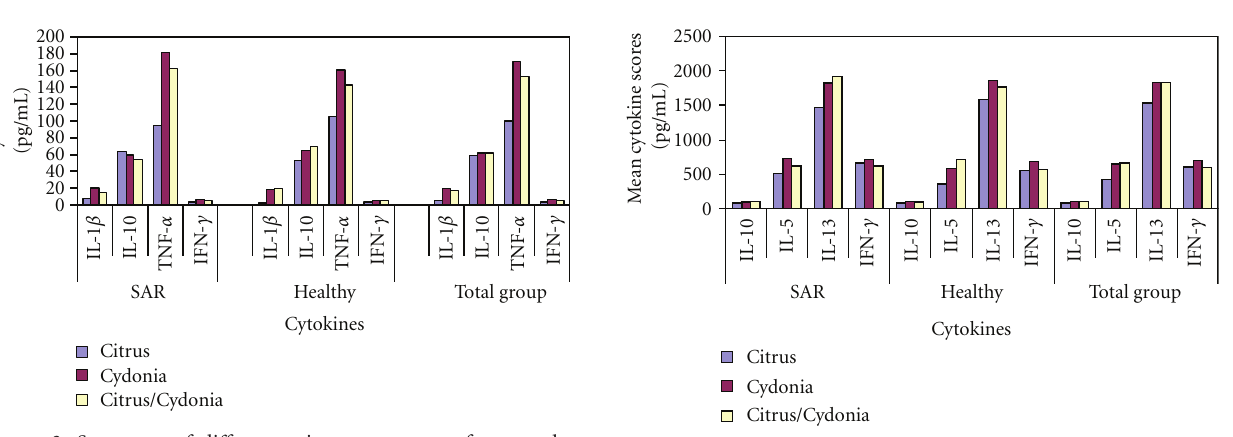
Figure 4: Summary of di ff erences in mean scores after seven days PBMC cultures in the SAR group, healthy group, and total